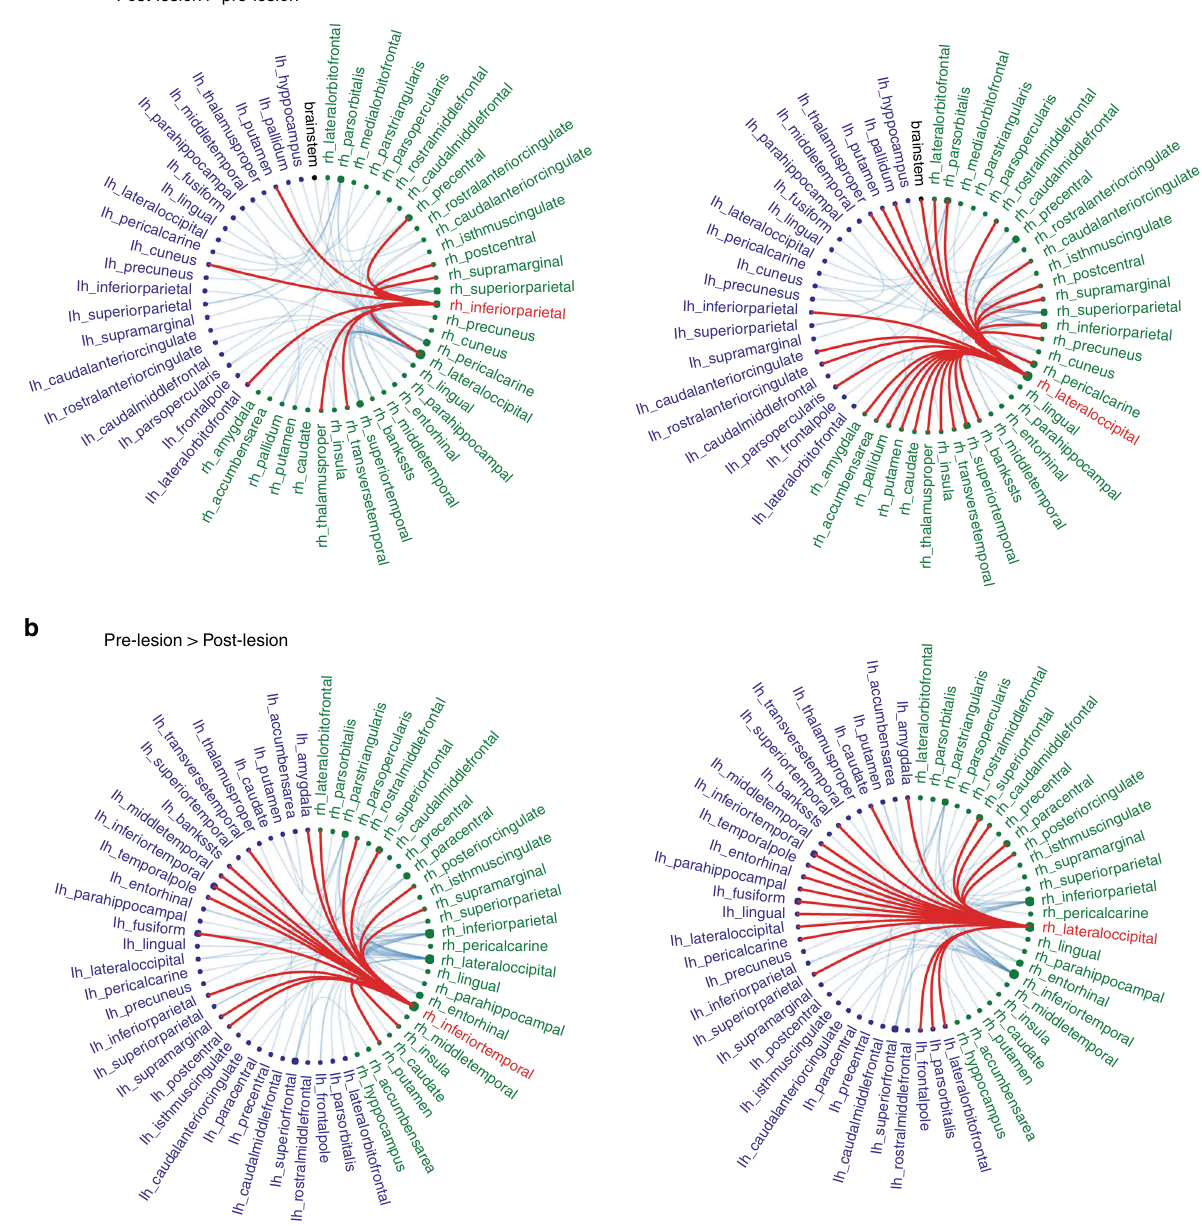
Fig. 6 Simulating the effect of an arti fi cial lesion to the right FFA on functional connectivity. Green and purple denote right and left hemispheric nodes respectively and the simulated edge differences which were signi fi cantly affected by the lesion are depicted by blue lines (edges) connecting the nodes. Red denotes a selected node and its statistically signi fi cant edges. a The right LOC and the right IPS nodes had the highest nodal degree in the post-lesion > pre-lesion contrast. b The right inferior temporal cortex and the right LOC nodes had the highest nodal degree in the pre-lesional > lesion